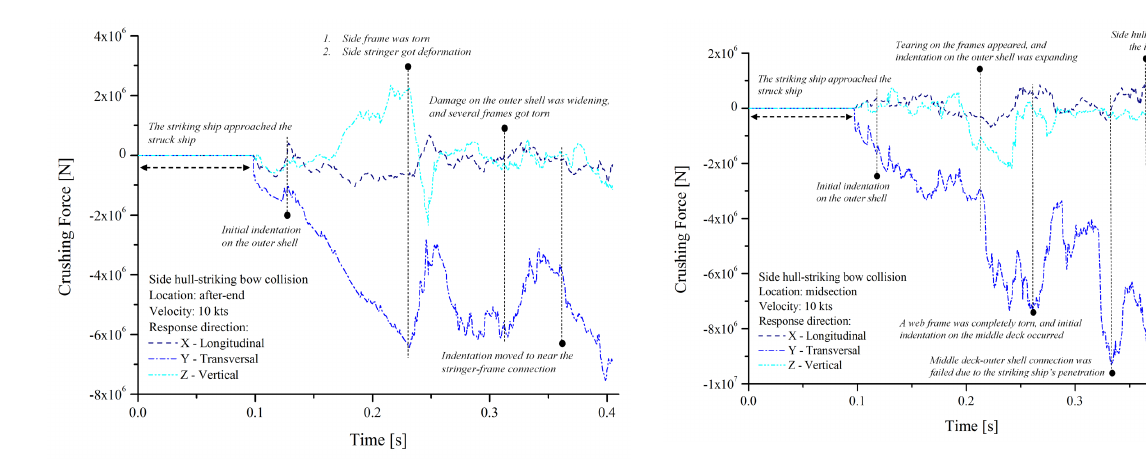
Figure 6: Patterns of crushing force, and sequences of progressive failure: after-end impacted by velocity 10 kts.